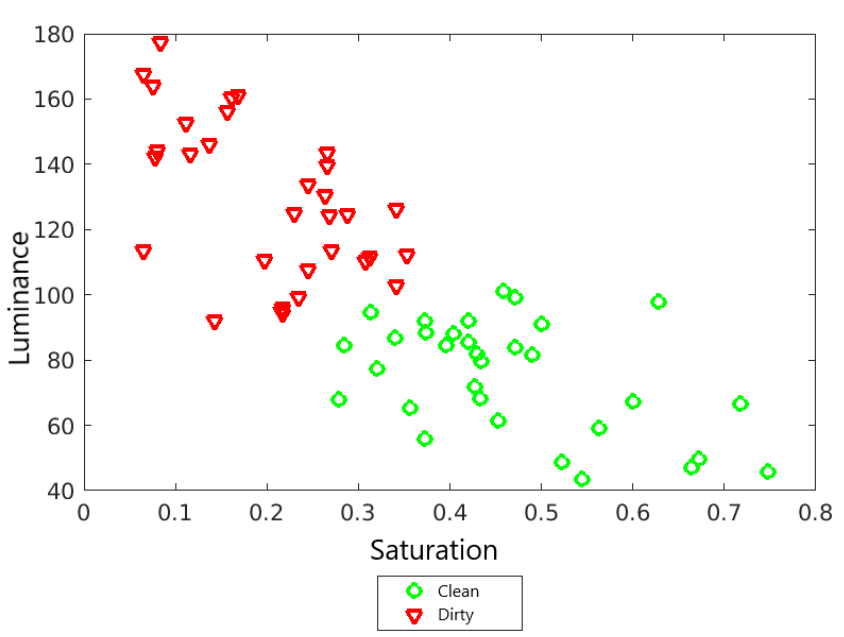
Figure 7. Observation